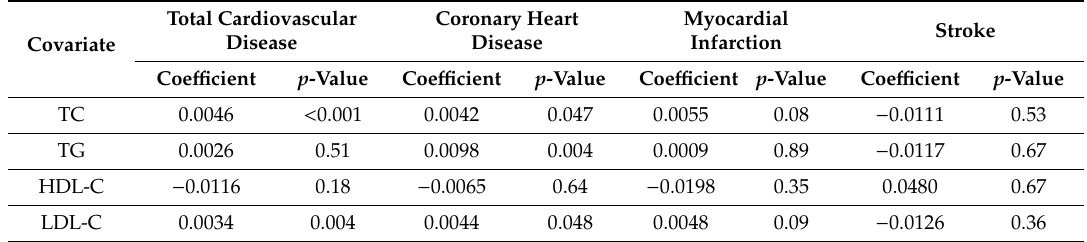
Table 4. Change difference in lipid profiles in the association with risk reduction of cardiovascular events. Table4. Changedi ff erenceinlipidprofilesintheassociationwithriskreductionofcardiovascularevents.